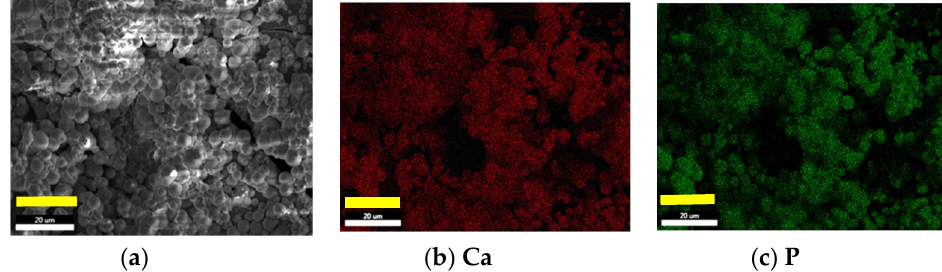
Figure 9. SCS8 aerogel after four weeks of immersion in SBF ( a ). Maps from EDX spectra of the ions distributions for the calcium ( b ) and phosphorus ( c ). (left bottom bar 20 μ m).